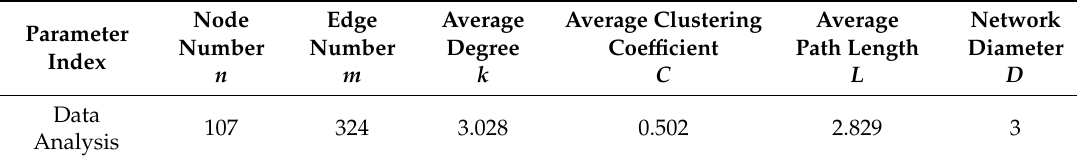
Table 2. Parameter analysis of the space-based information